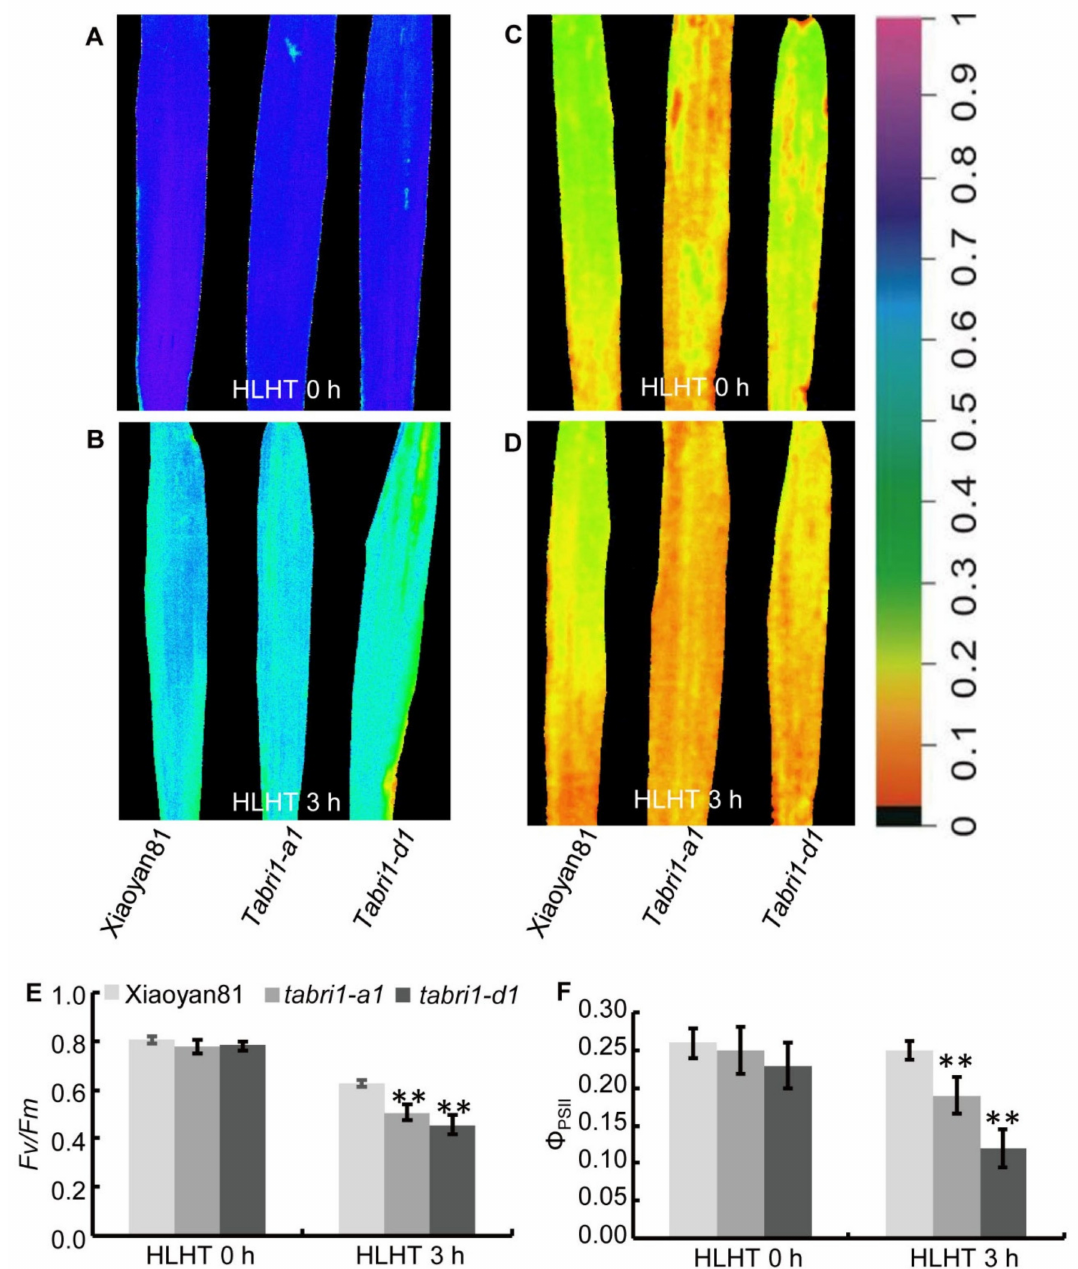
Figure 8. Chlorophyll fluorescence parameters of detached flag leaves in WT and TaBRI1 mutants at 21 DPA under HLHT 3 h. ( A – D ) Images of the maximum photochemical e ffi ciency ( Fv / Fm ) ( A , B ), actual PSII e ffi ciency ( Φ PSII ) ( C , D ) of WT and TaBRI1 mutants under HLHT 3 h. The color in ( A – D ) represents the value of each parameter in the color scale; ( E , F ) statistical analysis of Fv / Fm , Φ PSII in ( A – D ), respectively. Data are from three biologic replicates, and each biologic replicate comprised eight plants. ** indicates significant di ff erences between WT and TaBRI1 mutants at p < 0.01. To further confirm the role of TaBRI1 in wheat responses to HLHT stresses, the barley stripe mosaic virus (BSMV)-based virus-induced TaBRI1 silencing (VIGS) technique was used. The plants exhibiting significant BSMV infection symptoms were further cultured for three weeks and treated under HLHT 3 h (Figure 9A). The leaves with non-obvious BSMV symptoms were chosen to be measured the photosynthetic parameters (A, Gs and Ci) and the e ffi ciency of PSII ( Fv / Fm , Φ PSII and ETRs) to eliminate the interference of the visible bleached leaves due to the plant immunity to